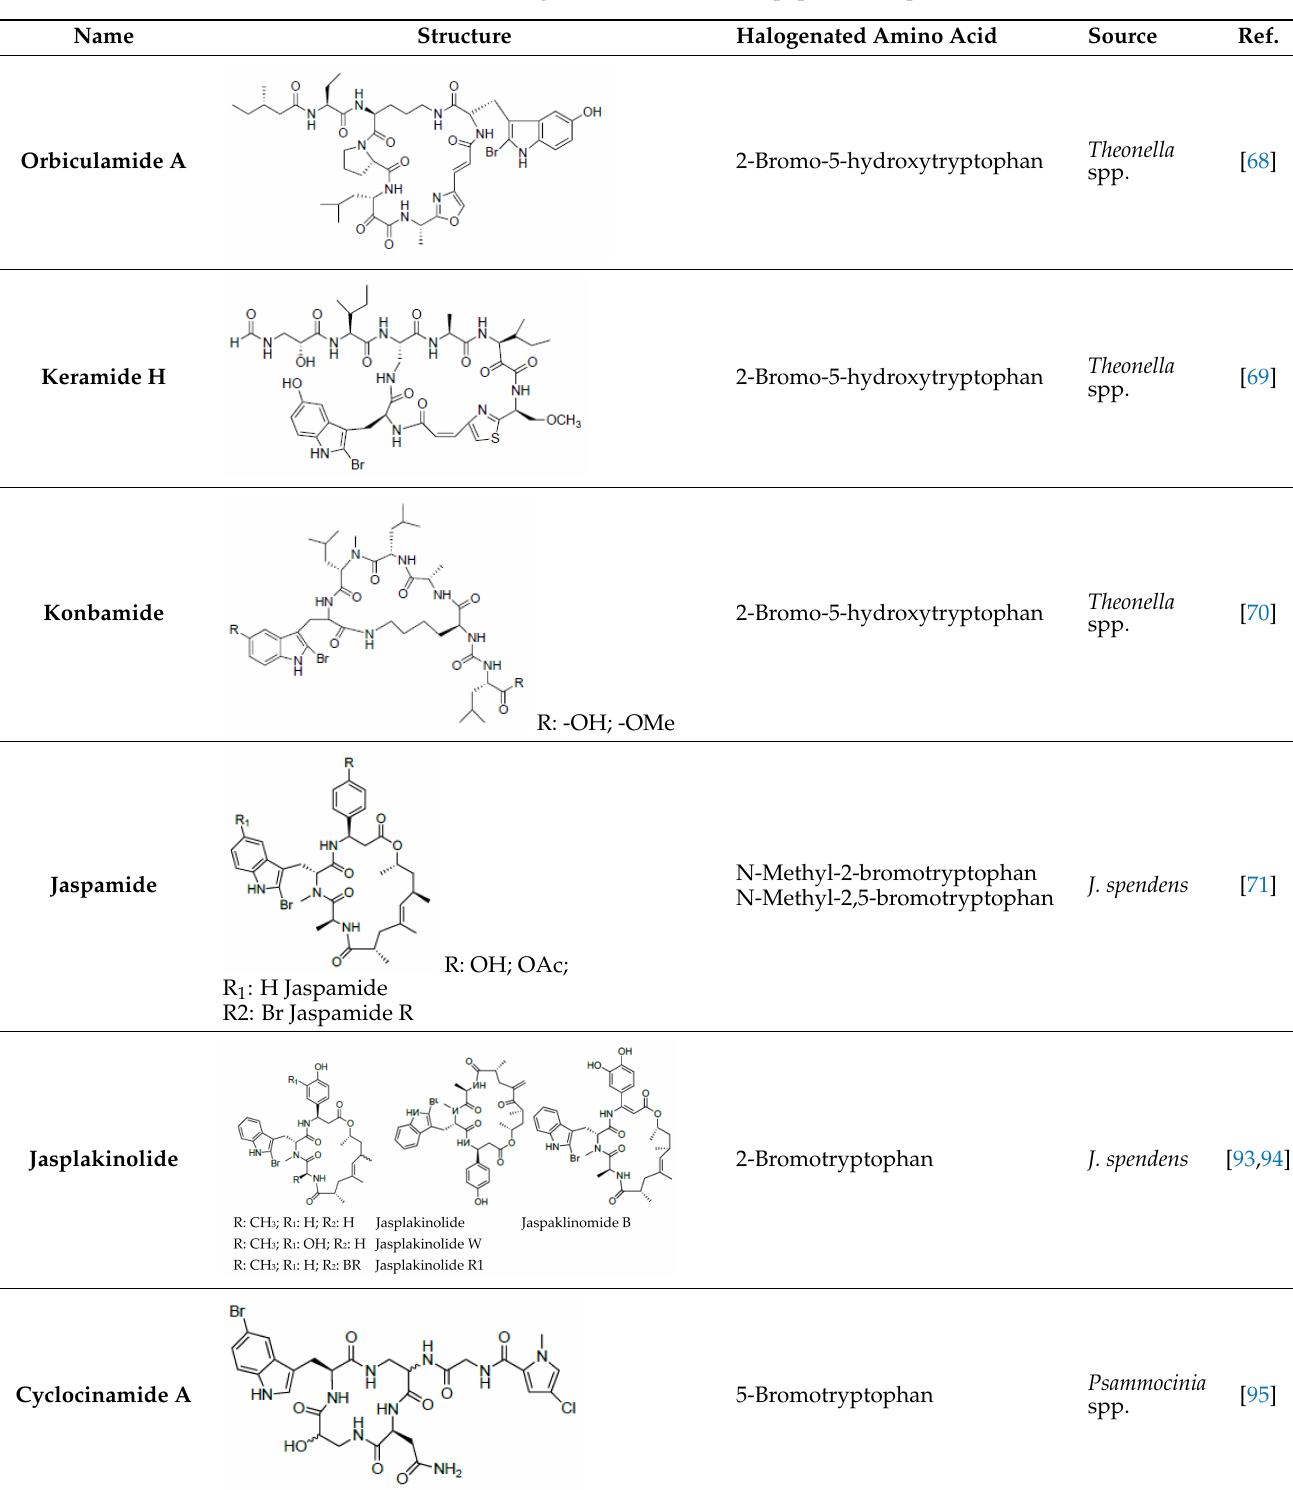
Table 2. List of a selection of halogenated non-ribosomal peptides, adapted from Ref.